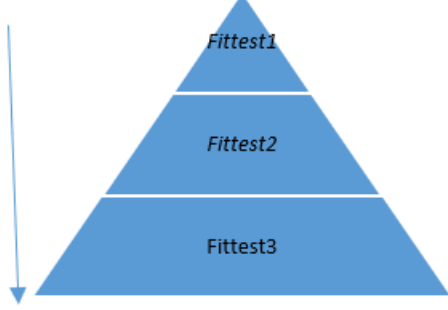
Figure 3. Fitness pyramid.